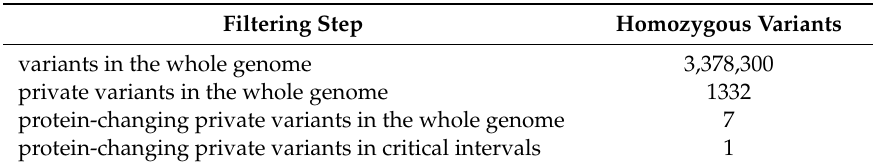
Table 1. Results of variant filtering in an a ff ected dog and 601 control